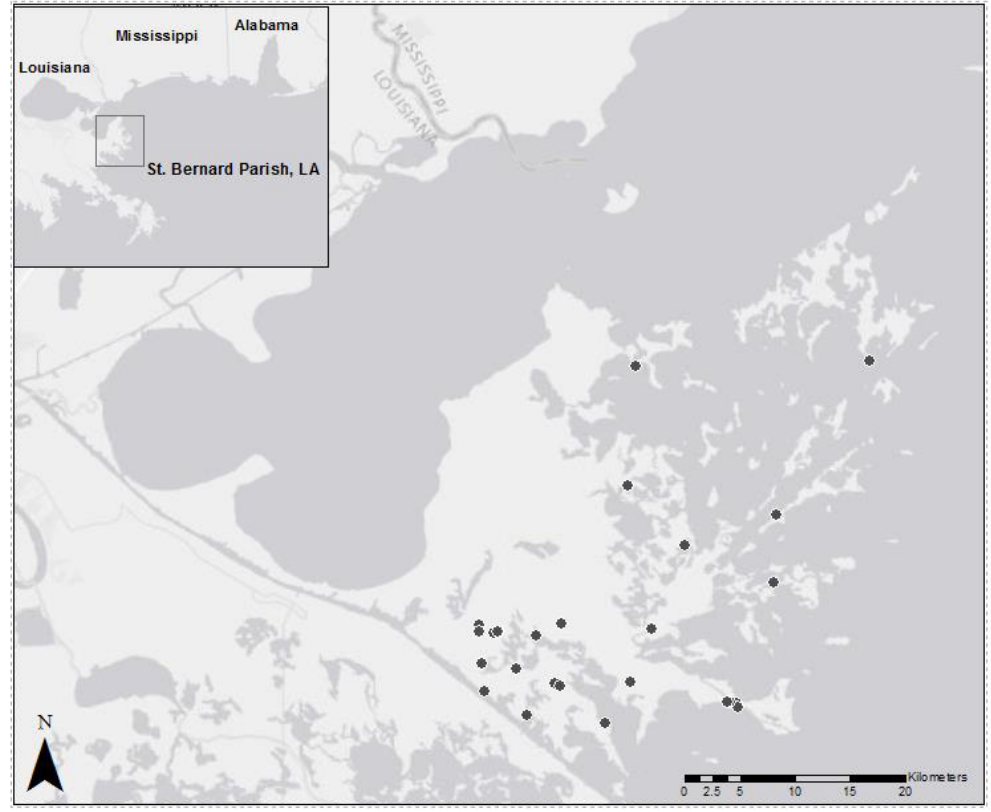
Location of the Biloxi Marsh and Observed Marsh Bank Feeding